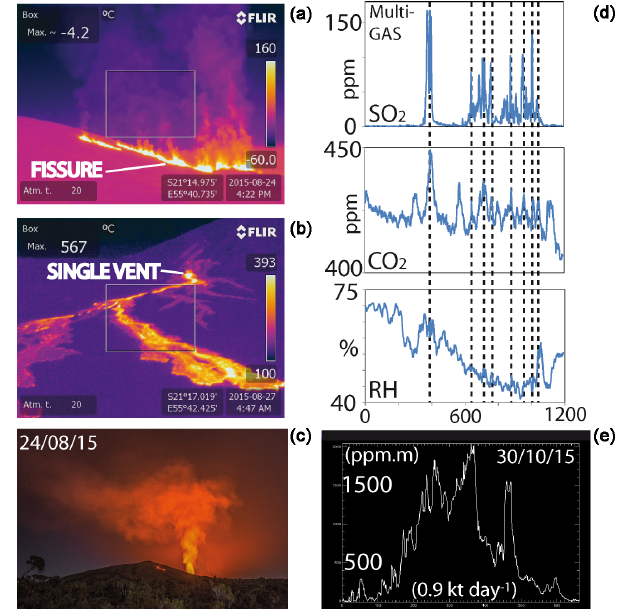
Figure 8. Night-time IR remote imagery (view from the Piton de Bert site on the southern cliff of the Enclos Fouqué caldeira (see Fig. 1) of the linear eruptive sources active at the beginning (a) and on the fourth day (b) of the major August 2015 eruption. (c) Tall gas and aerosol plume emitted by the linear source active at the begin- ning of the August 2015 eruption. (d) In situ analysis of volcanic gas emissions by the MultiGAS technique performed close to the eruptive vent (25 August 2015 eruption). Lines mark peaks which have been correlated in order to calculate molar ratios. (e) SO 2 col- umn density measured on 30 October 2015 by portable mini-DOAS in a traverse of the gas plume (Plaine des Sables site: 4.3km north- west from the eruptive